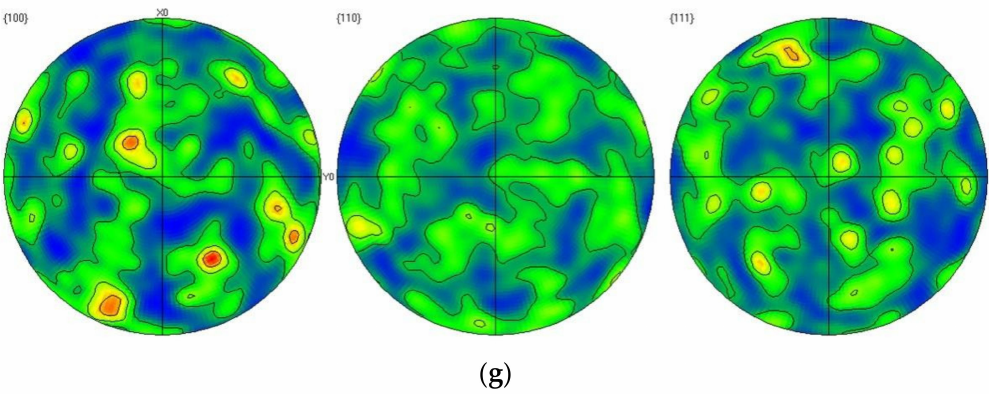
Figure 6. EBSD maps of non-heat-treated, die-cast samples after heat treatment: ( a ) X0 direction, ( b ) Y0 direction, ( c ) Z0 direction, ( d ) Al pole figures, ( e ) Si pole figures, ( f ) Al reverse pole figures, ( g ) Si reverse pole figures.